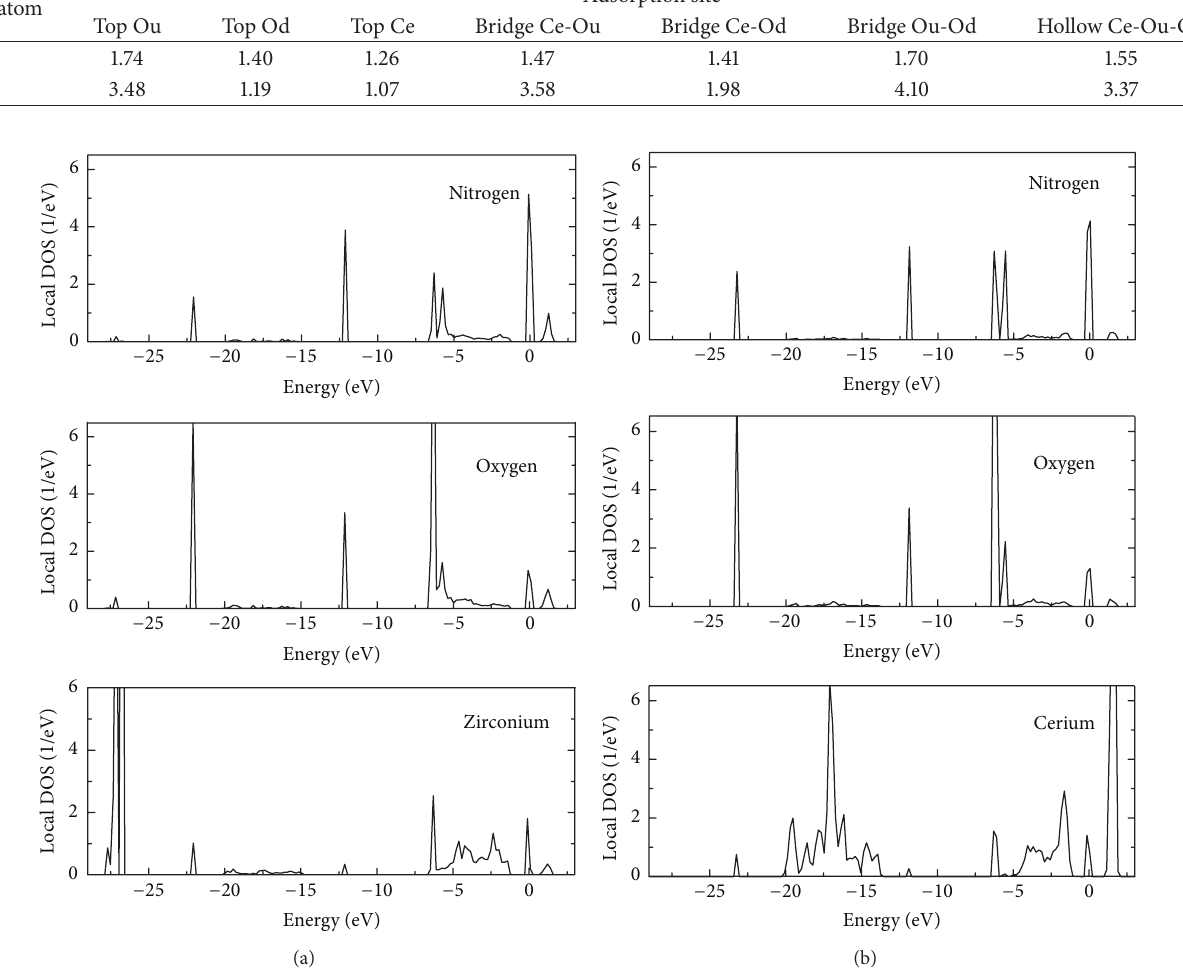
Figure 4: The DOS for the structure of a nitrogen atom on (a) Ce-segregation-free and (b) Ce-segregated CeSZ (111) surfaces.